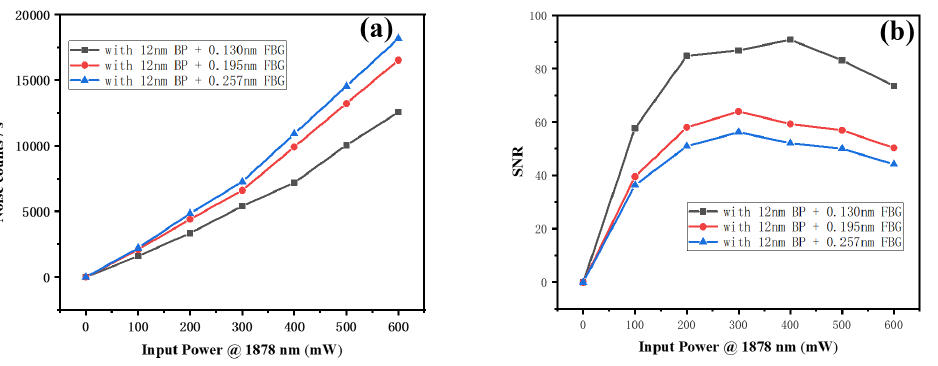
Figure 7. The noise suppression results. ( a ) The noise photon counts results obtained with three filters of different bandwidth respectively. ( b ) The SNR obtained with three filters of different bandwidths,